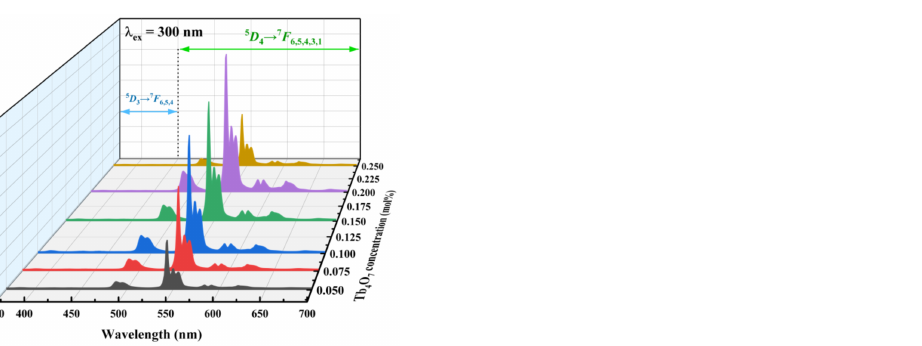
Figure 11. Emission spectra of (ZrO 2 ) 92 (Y 2 O 3 ) 8 − x (Tb 4 O 7 ) x ( x = 0.050–0.250) crystals before annealing.